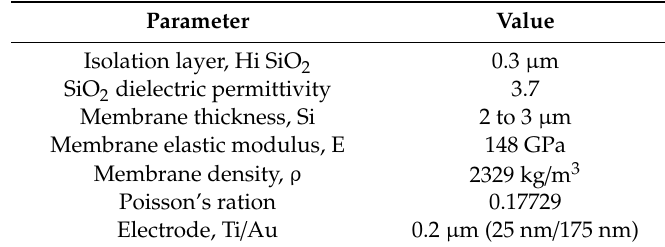
Table 1. Parameters used for materials.